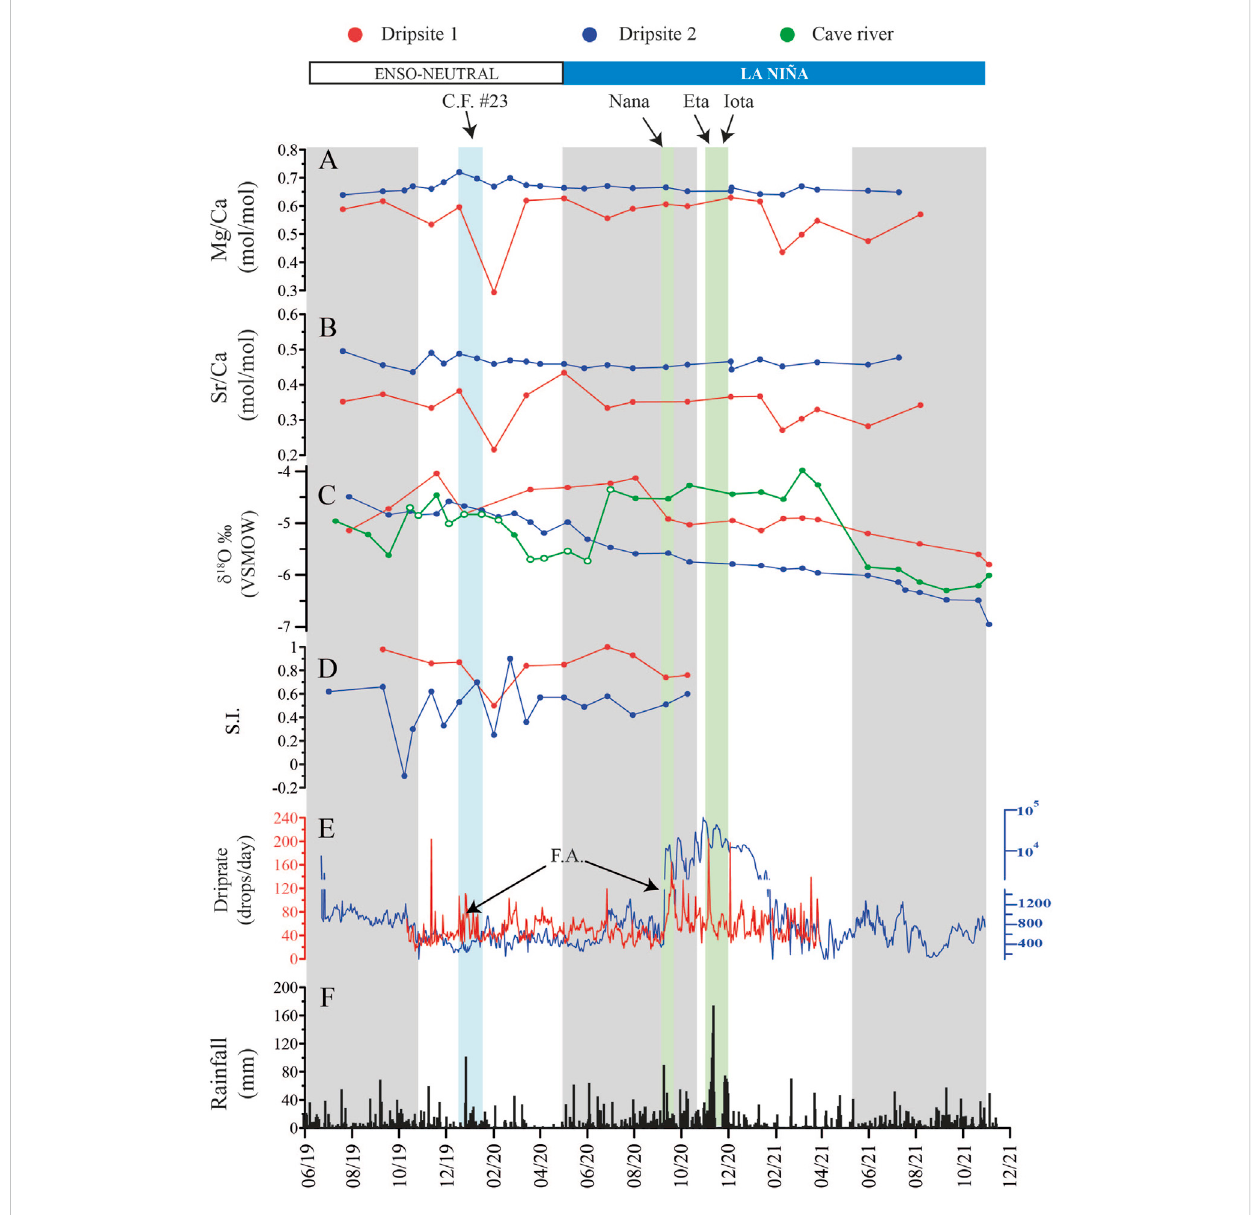
FIGURE 5 Time-series of (A) Mg/Ca, (mol/mol) (B) Sr/Ca (mmol/mol), (C) δ 18 O ‰ (VSMOW)¸ (D) calcite saturation indices (Parkhurst and Appelo, 1999), (E) driprate,and (F) recordedrainfallatCobanAirportduringthemonitoringperiod.NotethatthedriprateforDS2(rightside)isinitiallyatlinearscale,butdue to the signi fi cant increase in drip-rate continues on log-scale. Gray, blue and green stripes are the same as in Figure